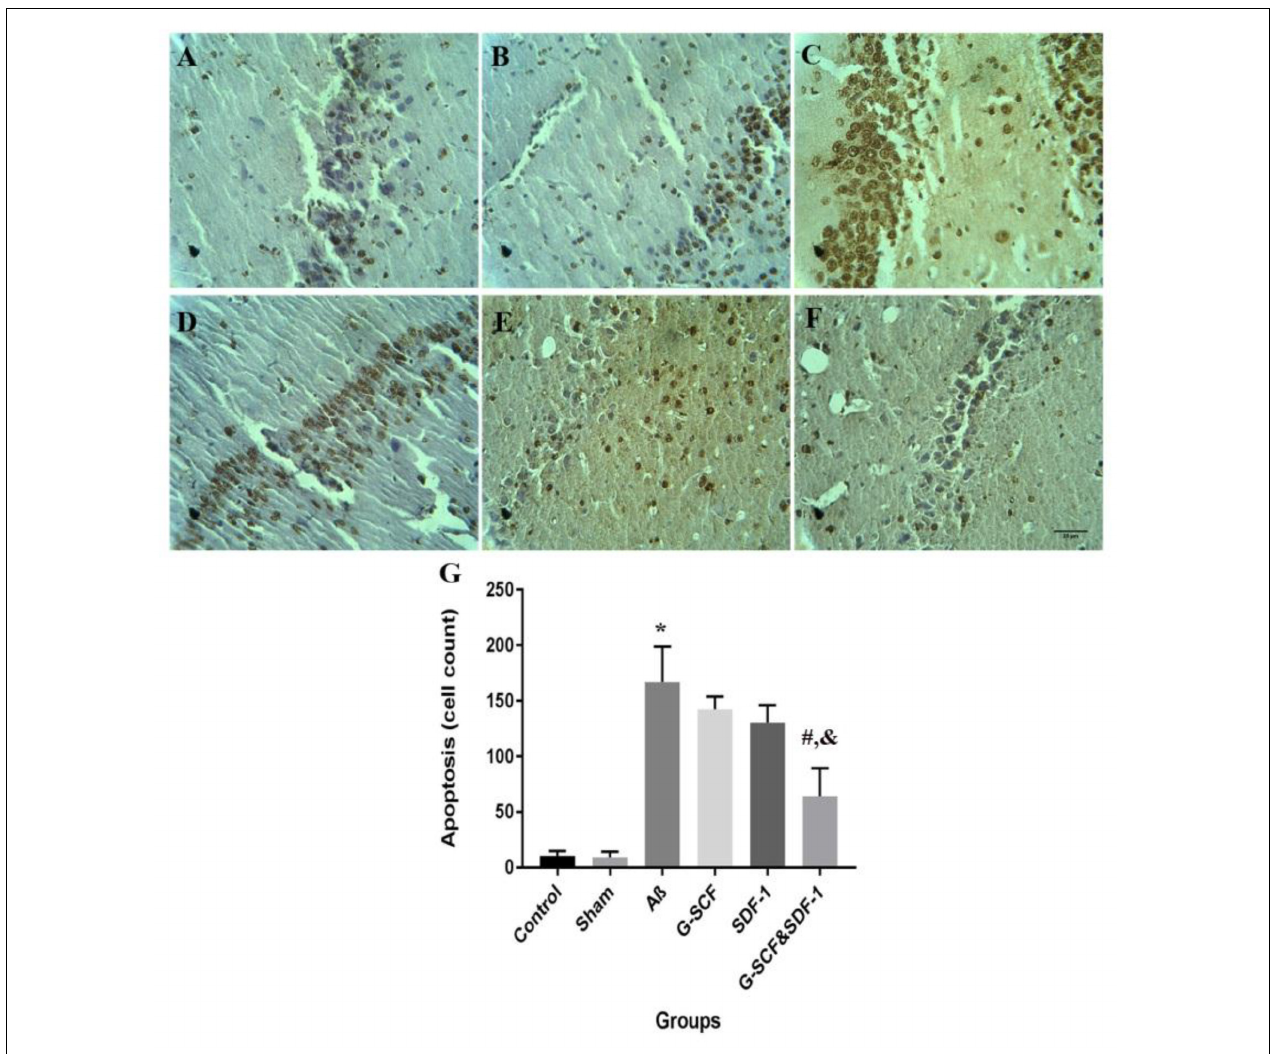
FIGURE 9 | Light micrographs illustrated the apoptosis cell in the CA1 region of hippocampal. (A) Sections derived from the (A) control; (B) sham; (C) A β ; (D) G-CSF; (E) SDF-1; and (F) SDF-1&G-CSF groups. (G) The mean of apoptotic cell count was calculated. (* P < 0.01) as compared with control group. (# P < 0.05) as compared with G-SDF and SDF-1 groups. (& P < 0.05) as compared with A β . Each column represents Mean ±